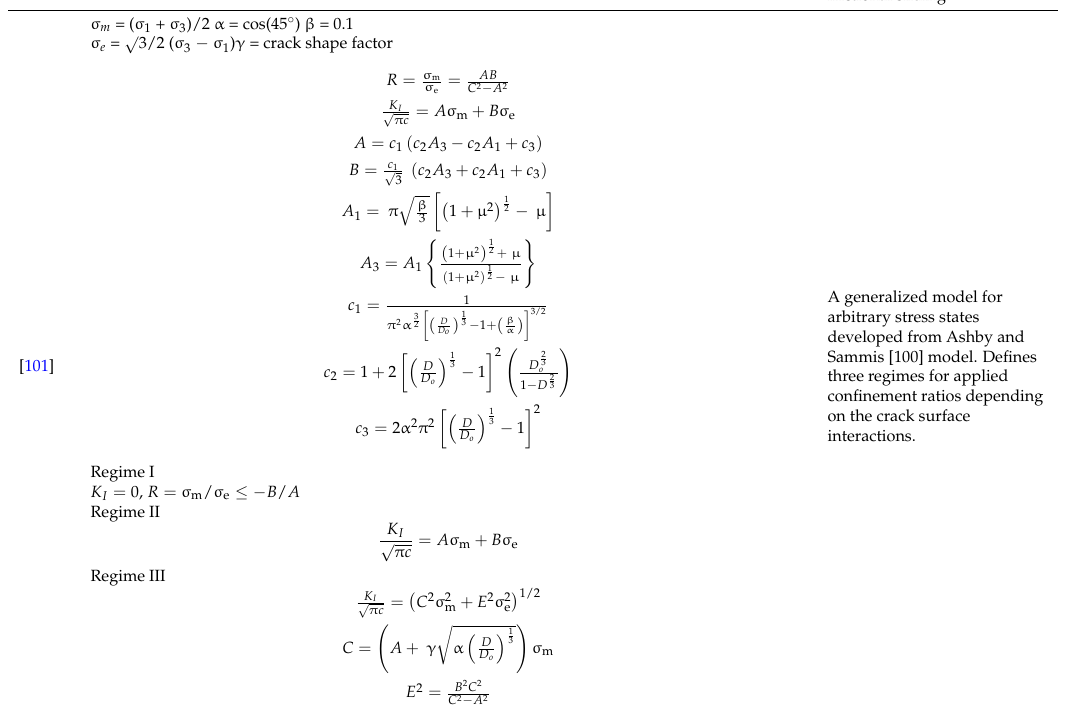
A generalized model for arbitrary stress states developed from Ashby and Sammis [100] model. Defines three regimes for applied confinement ratios depending on the crack surface